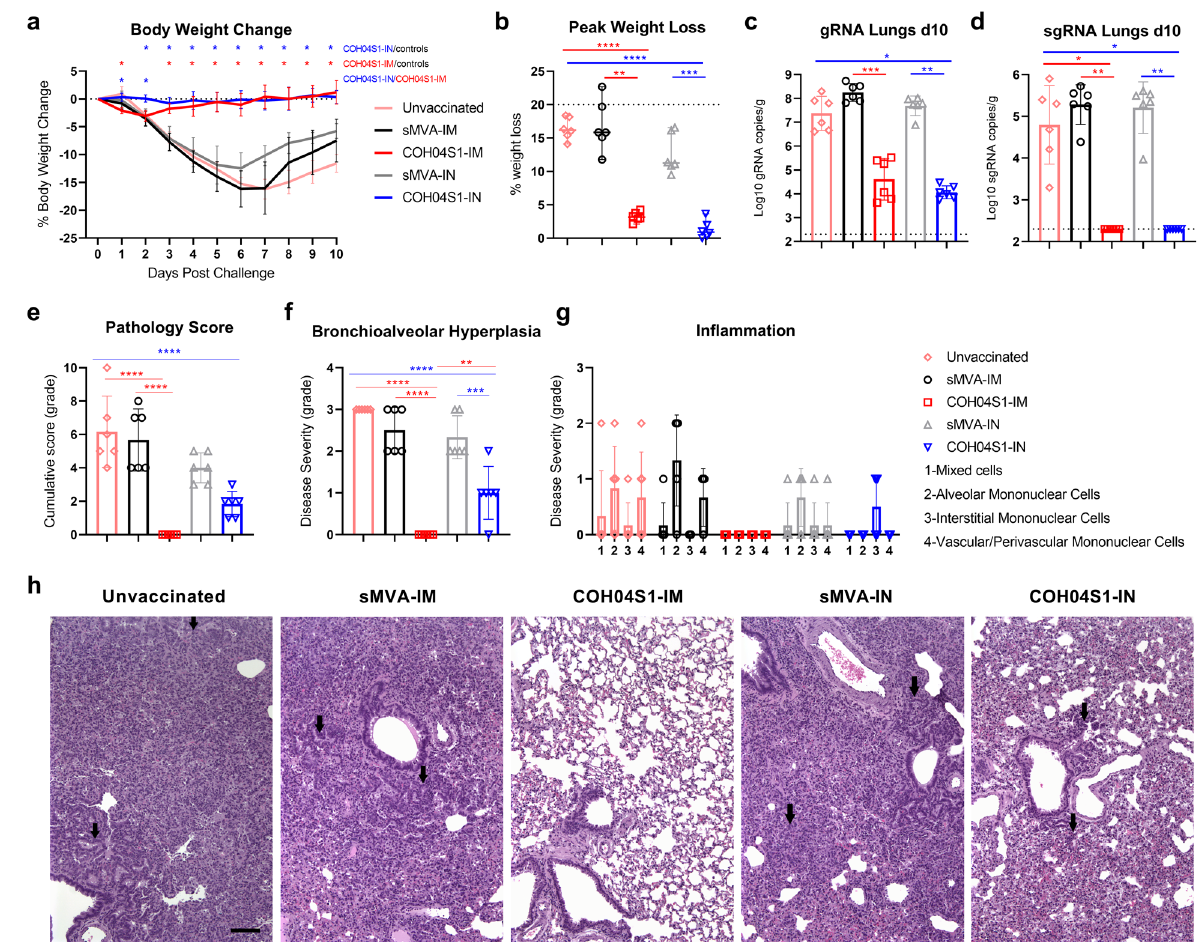
Fig. 2 COH04S1-mediated vaccine protection in hamsters following sub-lethal SARS-CoV-2 challenge. a. Body weight change. Body weight of COH04S1-IM and COH04S1-IN-vaccinated animals and unvaccinated and sMVA-IM and sMVA-IN vector control animals was measured daily for 10 days post-challenge. Weight loss is reported as mean ± s.d. Two-way ANOVA followed by Tukey ’ s multiple comparison test was used to compare group mean values at each timepoint. b Maximal weight loss. Percentage of maximal weight loss is shown in single animals of vaccine and control groups. Lines and bars represent median values and 95% CI, respectively. Dotted line represents the maximum weight loss allowed before euthanasia. Peaks of weight loss in each group were compared using one-way ANOVA followed by Tukey ’ s multiple comparison test. c – d Lung viral loads. SARS-CoV-2 genomic RNA (gRNA) and sub-genomic RNA (sgRNA) copies were quanti fi ed in lung tissue of vaccine and control groups at day 10 post-challenge by qPCR. Bars show RNA copies geometric mean ± geometric s.d. Dotted lines represent lower limit of detection. Kruskal – Wallis test followed by Dunn ’ s multiple comparison test was used. e – h Histopathological fi ndings. Hematoxylin/eosin-stained lung sections of COH04S1-vaccinated hamsters and control animals at day 10 post challenge were evaluated by a board-certi fi ed pathologist and microscopic fi ndings were graded based on severity on a scale from 1 to 5 (Supplementary Table 2). Panel e shows the cumulative pathology score of all histopathologic fi ndings in each group. Panel f shows grading of bronchioalveolar hyperplasia disease severity in each group. One-way ANOVA followed by Holm-Sidak ’ s multiple comparison test was used in e and f . Panel g shows the severity of lung in fl ammatory microscopic fi ndings based on 1-to-5 scaling of four in fl ammation types as indicated. One-way ANOVA followed by Tukey ’ s multiple comparison test was used. Bars in e – g represent mean values ± s.d. *0.05 < p < 0.01, **0.01 < p < 0.001, ***0.001 < p < 0.0001, **** p < 0.0001. Panel h shows representative images of histopathological fi ndings in lung sections of COH04S1- vaccinated animals and control animals. Black arrows indicate moderate and mild bronchioalveolar hyperplasia in lung sections of sMVA-IM and sMVA-IN vector control animals as well as COH04S1-IN-vaccinated animals. Black arrows in lung sections of unvaccinated control animals indicate hyperplastic alveolar cells. 10x magni fi cation. Scale bar = 100